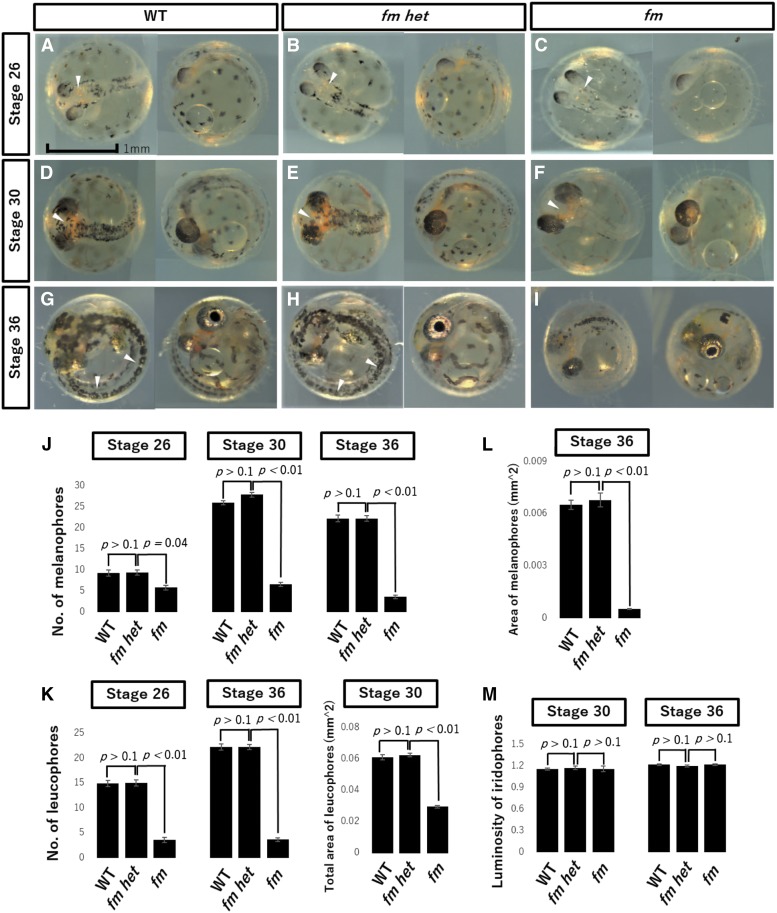
The numbers of melanophores and leucophores are reduced in embryos of fm medaka. (A–I) Photographs of WT (A, D, G), fm het (B, E, H), and fm (C, F, I) medaka embryos at stage 26 (A–C), stage 30 (D–F), or stage 36 (G–I). Arrowheads indicate a reduced number of leucophores on the dorsal head (A–C), a narrower area of leucophore pigmentation (D–F), or stage 36 (G–I) in fm medaka compared with WT or fm het embryos. Scale bar, 1 mm. (J) Number of melanophores in embryos of the three genotypes at stages 26, 30, and 36. (K) Number or total area of leucophores at stages 26 and 36 or at stage 30, respectively. (L) Area of individual melanophores at stage 36. (M) Luminosity value of iridophores at stages 30 and 36. All quantitative data are means + 95% confidence interval (n =15 larvae for each genotype). The p values were determined by one-way ANOVA followed by Tukey’s post hoc test.